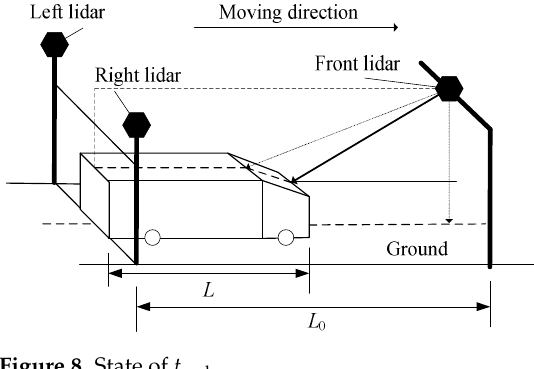
Figure 8. State of t end .